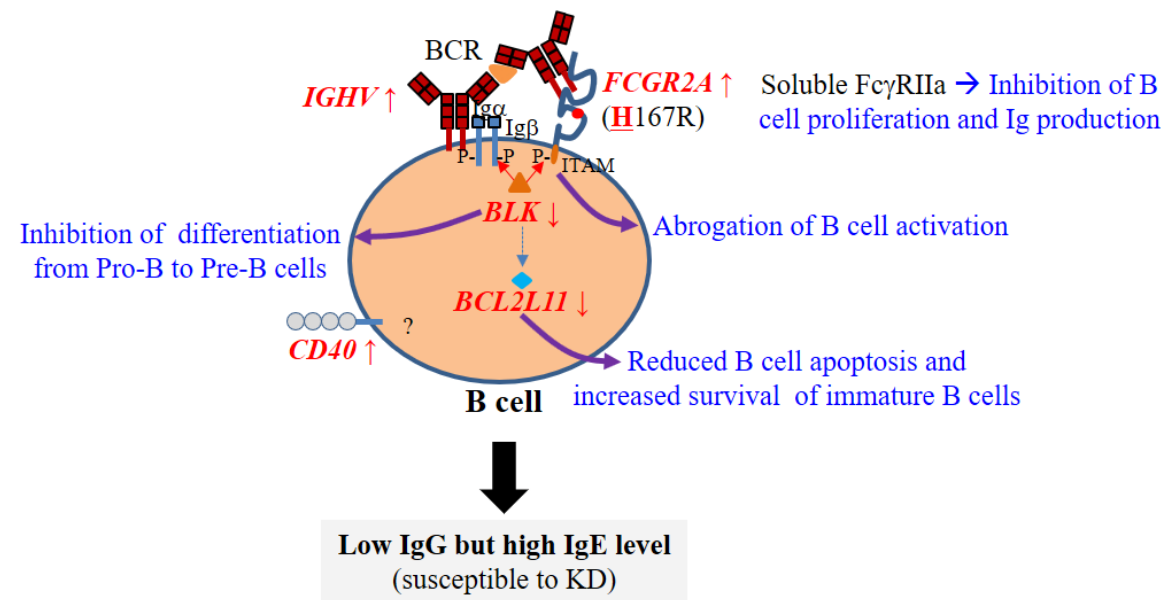
Figure 4. Genetic studies support early B cell–mediated pathogenesis of KD. The effect of risk alleles of KD susceptibility genes on mRNA expression is shown by arrows ( ↑ : upregulation and ↓ : downregulation). BCR, B cell receptor; KD, Kawasaki disease.